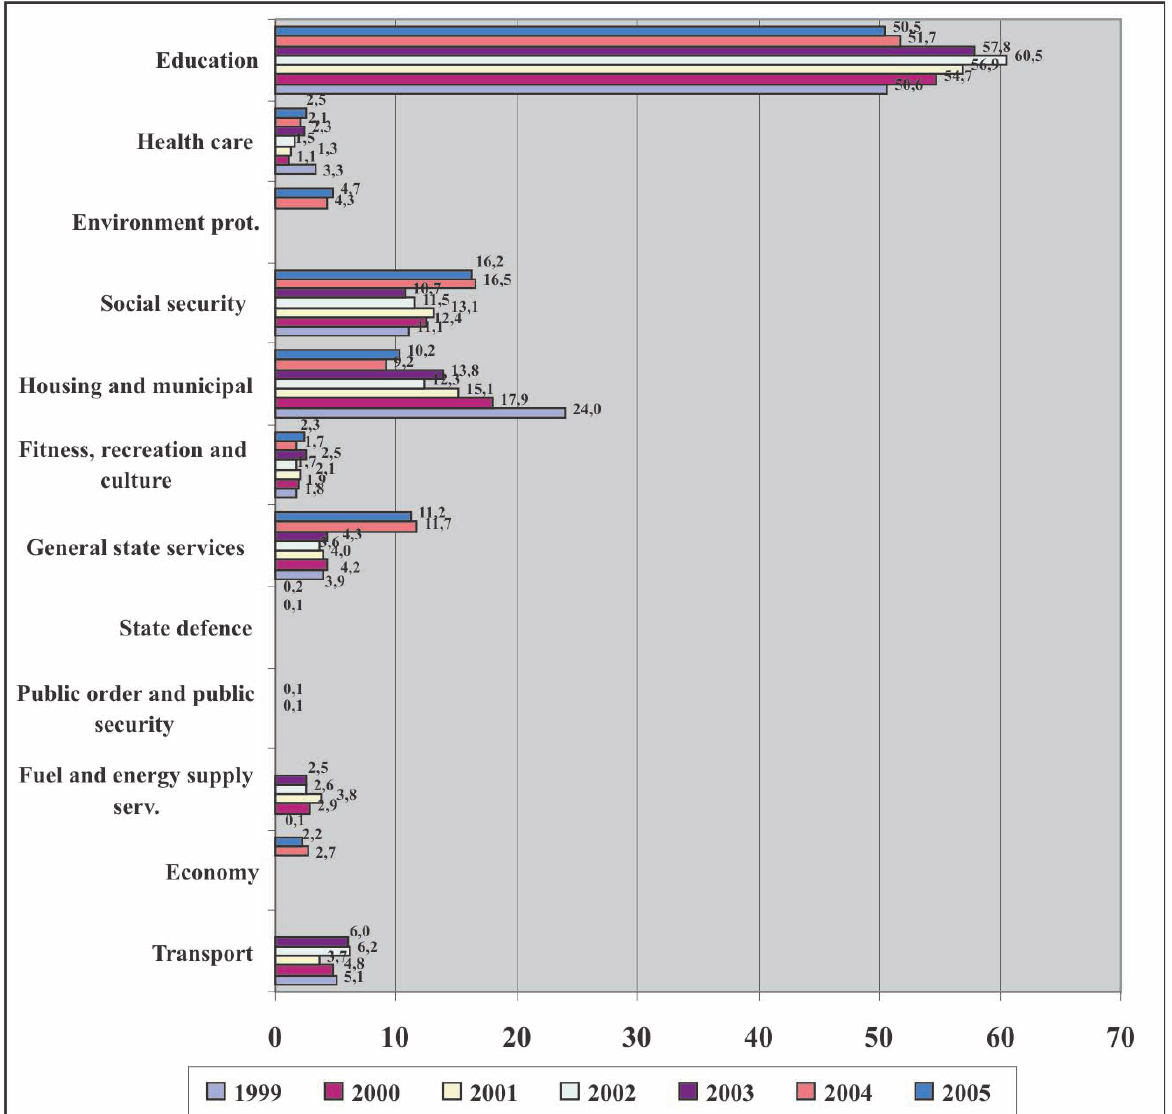
Fig 4. Expenditure from Vilnius city municipality budget for the sectors which employ more women or more men (%) Source: Resolutions of the Council of Vilnius municipality on approval of the budget of Vilnius city municipality for 1999–2005.